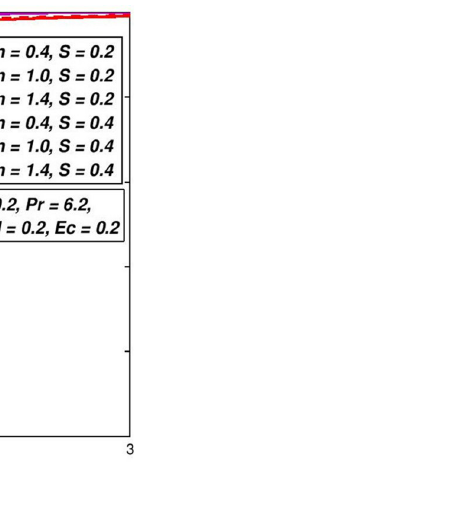
Fig 14. Effect of S > 0 on f 0 ( η ) for diverse n